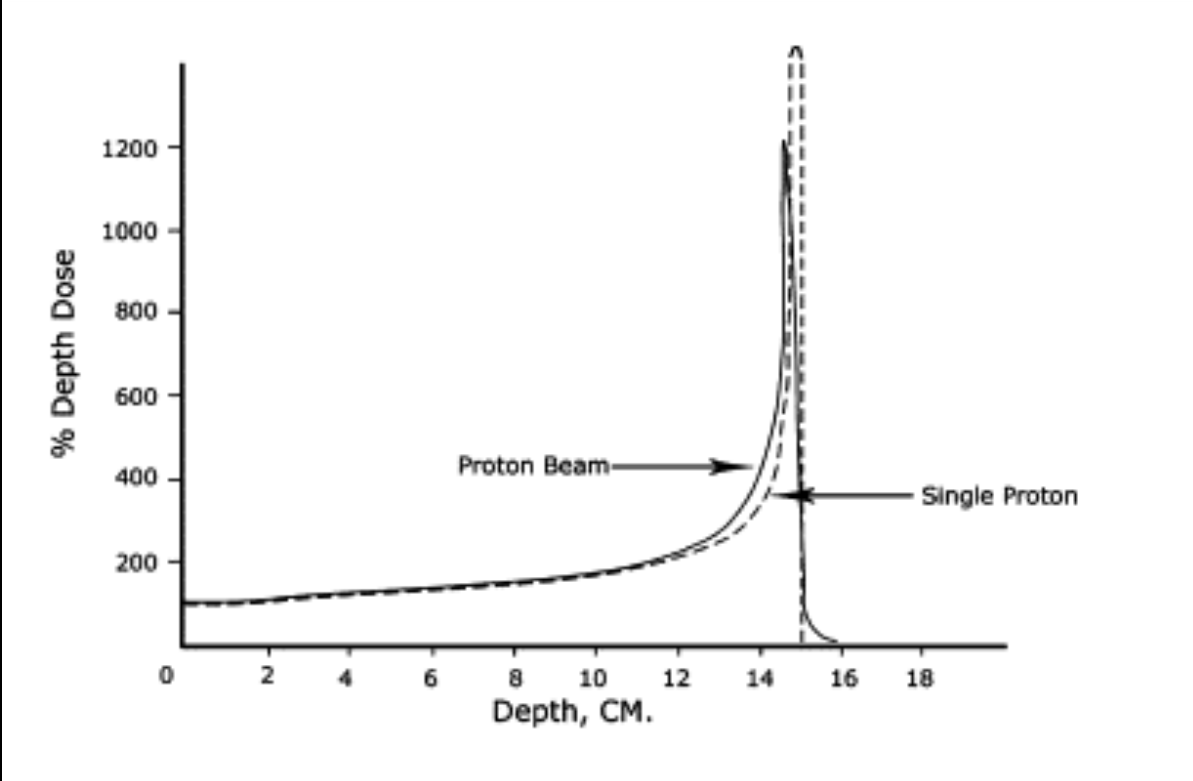
Figure 1. Depth dose curves for a 140 MeV proton beam versus a single proton, highlighting the “Bragg Peak” effect [2].